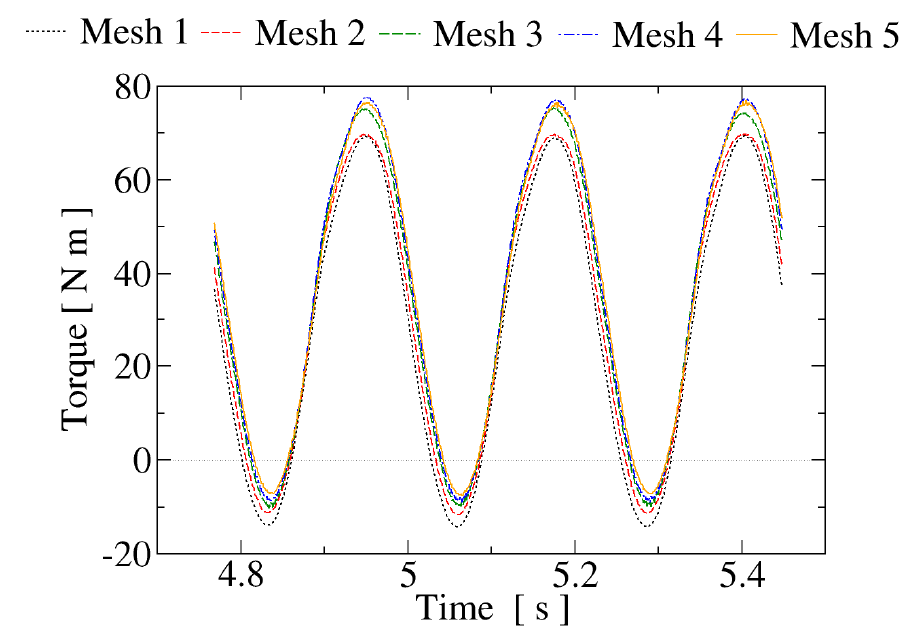
Figure 5. Evolution of the torque in time for the different meshes (SM, TSR = 2).